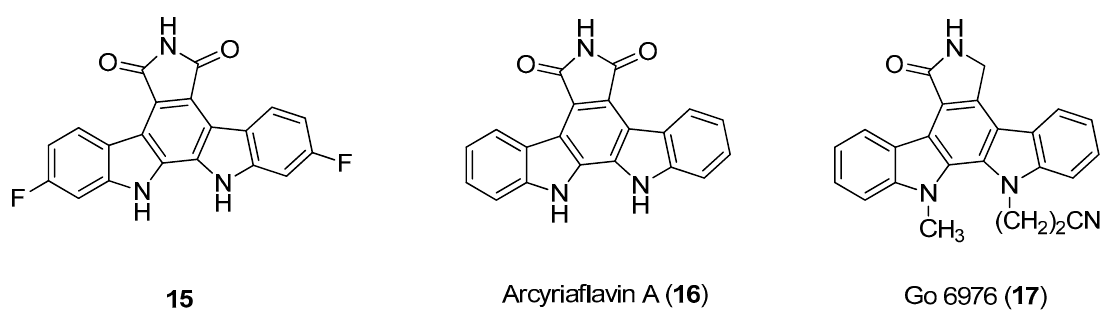
Figure 6 : Structures of 12,13-dihydro-2,10-difluoro-5 H -indolo[2,3-a]pyrrolo[3,4-c]carbazole-5,7-(6 H )- dione ( 15 ), Arcyriaflavin A ( 16 ), and Go 6976 ( 17 ).